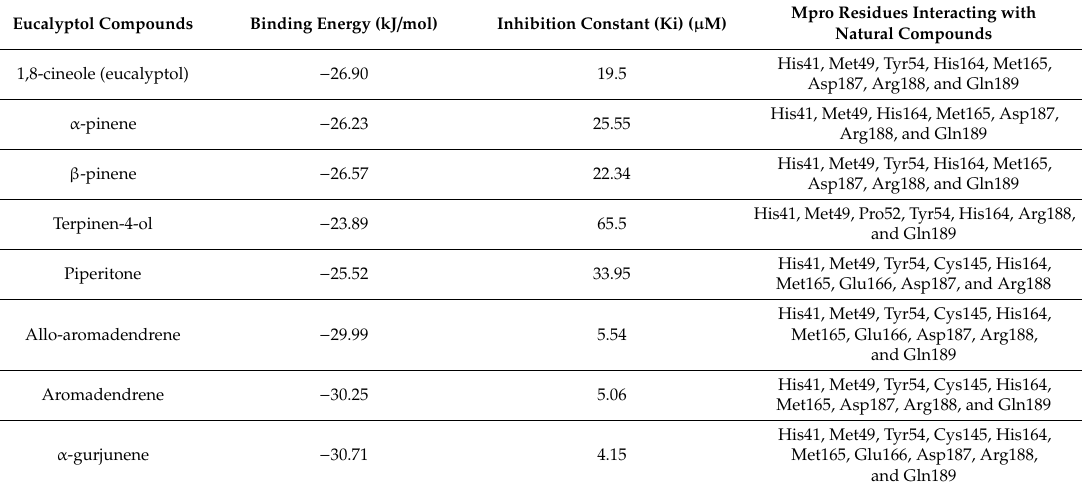
Table 2. Estimated lowest binding energies of main protease (Mpro) in complex with eucalyptus compounds obtained from molecular docking calculations along with inhibition constants and interaction